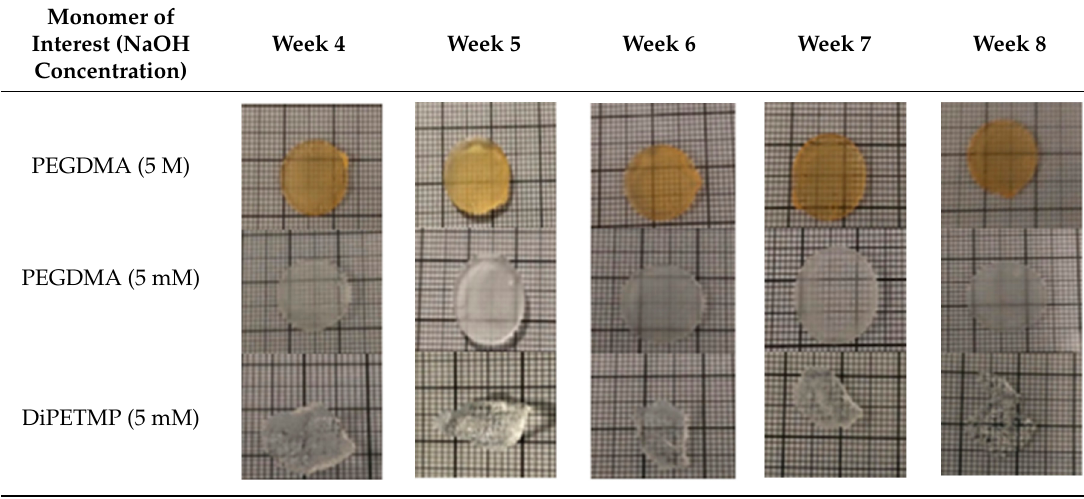
Figure 12. Degradation study of the PEGDMA and DiPETMP samples stored in 1. 5M NaOH and 2. 5 mM NaOH at 37 °C, over a 63 days period. Table 4. The changes to the hydrogel morphology during the accelerated degradation study, from weeks 4 to 8.